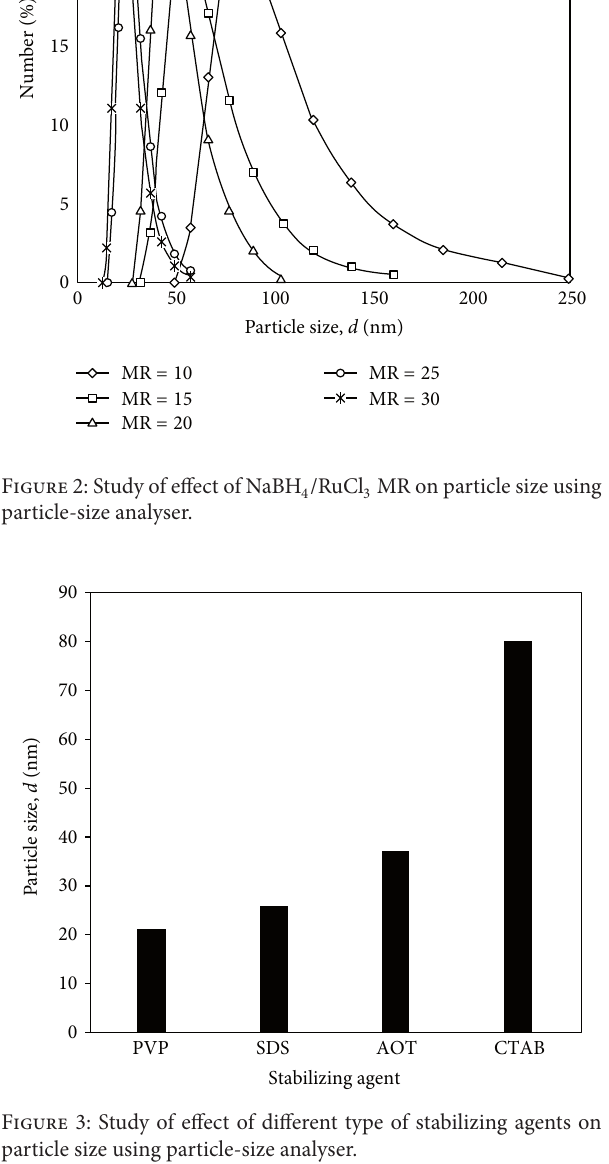
F 3: Study of effect of different type of stabilizing agents on particle size using particle-size